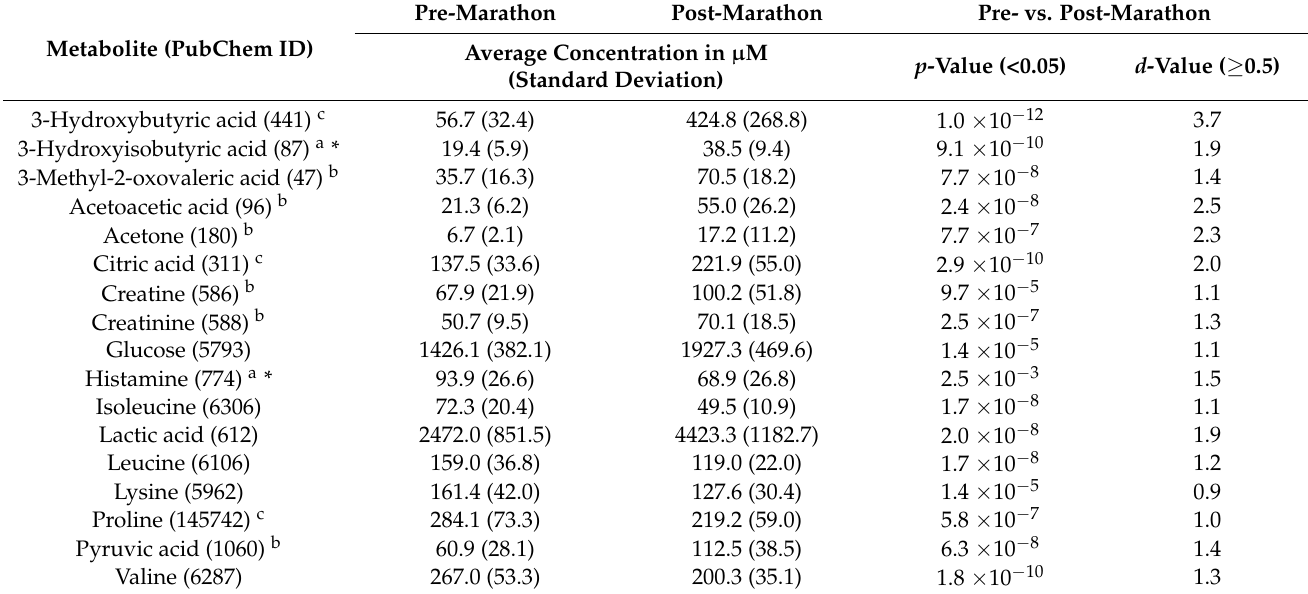
Table 1. Statistically significant marathon-induced metabolite